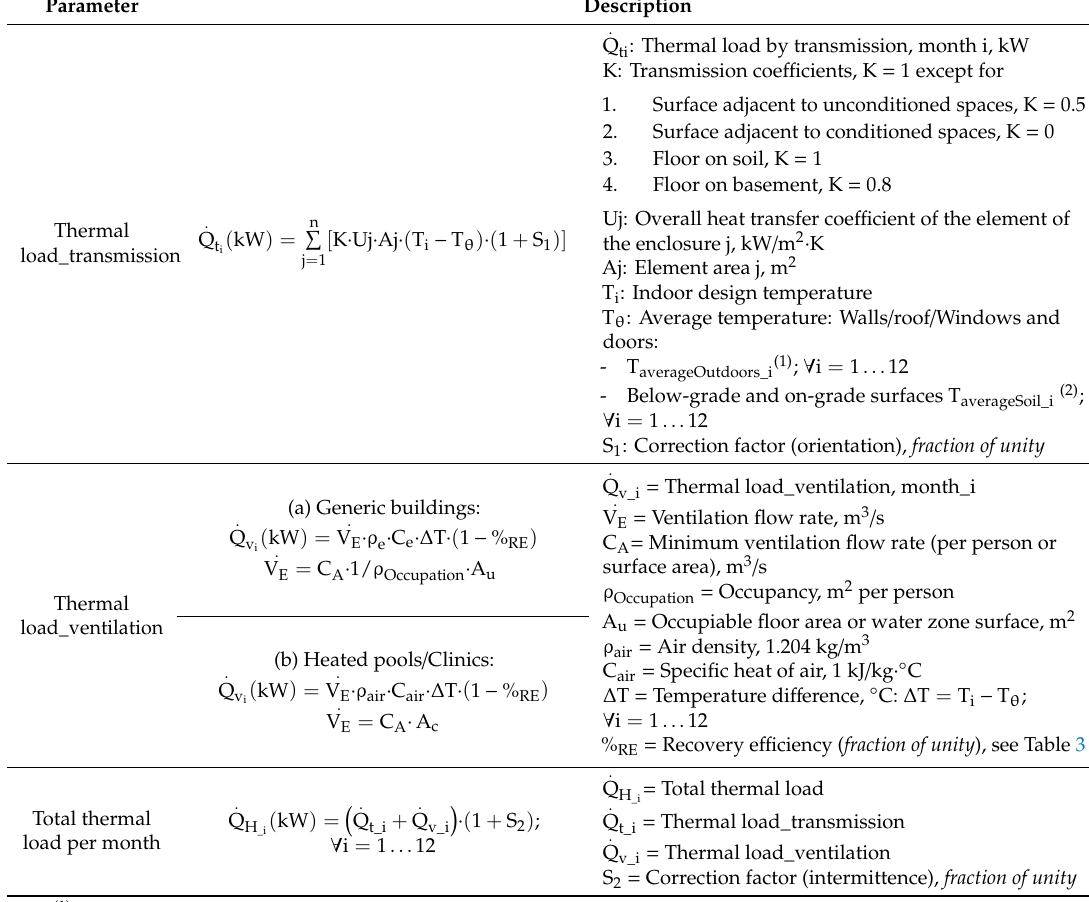
Table A4. Heat load for heating.